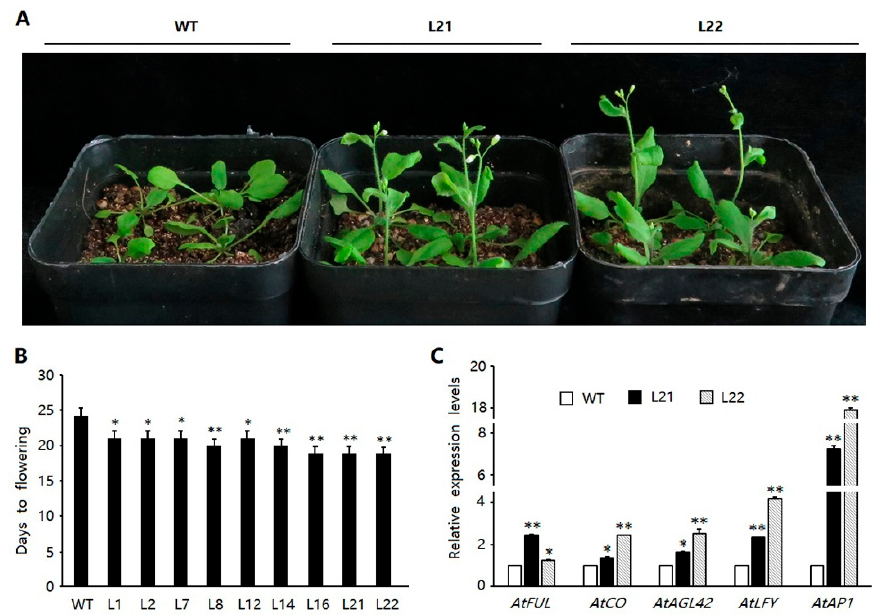
Figure 5. Overexpression of FvSPL10 in Arabidopsis promotes early flowering. ( A ) Phenotypes of 3-week-old plants under long-day conditions. Wild-type (WT) Arabidopsis ; L21, L22, homozygous transgenic lines with overexpression of FvSPL10 . ( B ) Comparison of flowering time between WT and transgenic plants. The value of each column represents mean SD ( n = 12). ( C ) Relative transcript levels of flowering-related genes in WT and transgenic lines. Two transgenic lines, L21 and L22 were selected as representatives. Single or double stars at the top of each column in the figure represent a significant difference among different lines at 0.01 < p ≤ 0.05 and p < 0.01, respectively, based on the Student’s t -test.